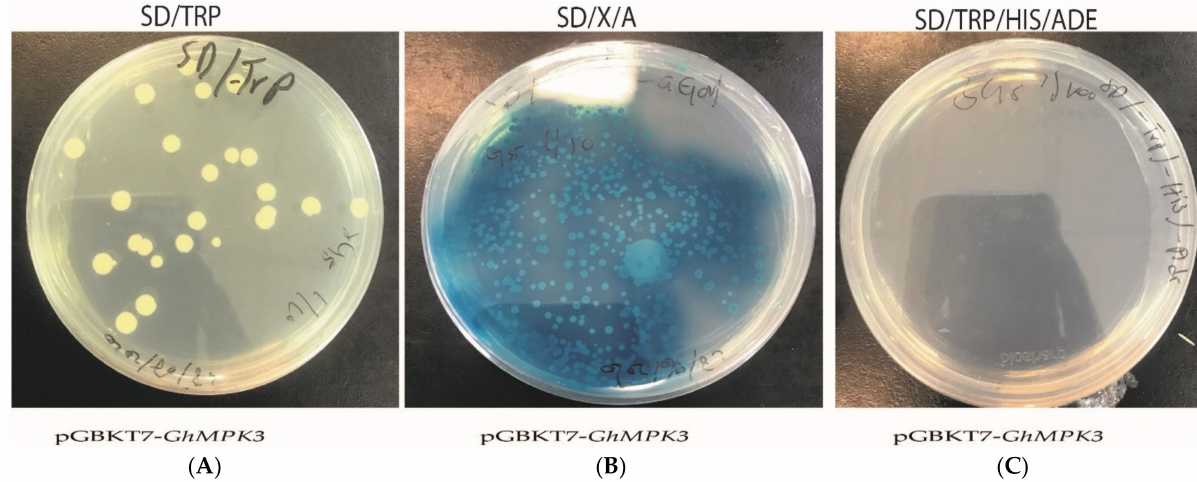
Figure 11. Determination of the auto-activation activity of GhMPK3 gene. The constructs were transformed into Y2HGold yeast cells and plated on a GhMPK3 gene on ( A ) SD/-TRP, ( B ) SDO/X/A, ( C ) SD/-TRP-HIS-ADE media and incubated for 3 days at 30 ◦